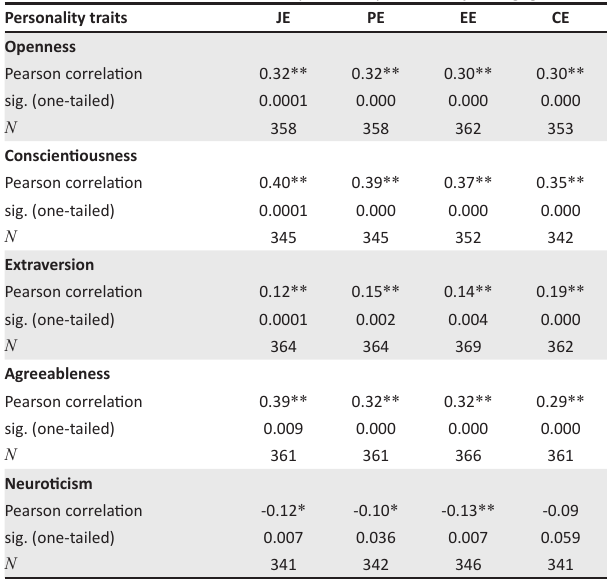
TABLE 4: Pearson correlation between personality traits and job